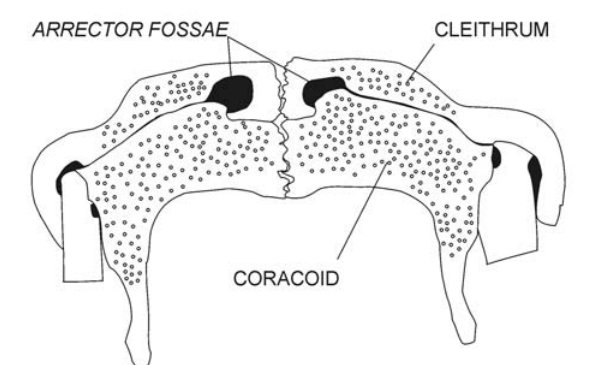
Fig. 2. Ventral view of pectoral girdle of Parotocinclus bidentatus , MNRJ 14217, c&s, 32.5 mm